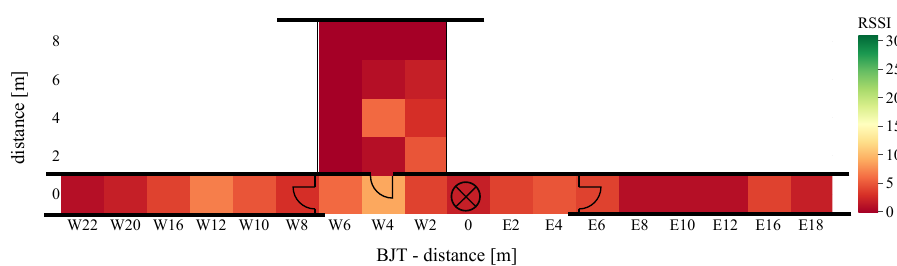
Figure 26. RSSI of BJT board with WuRx and WuTx on different floors. TIA implementation was not able to receive a single packet at this floor